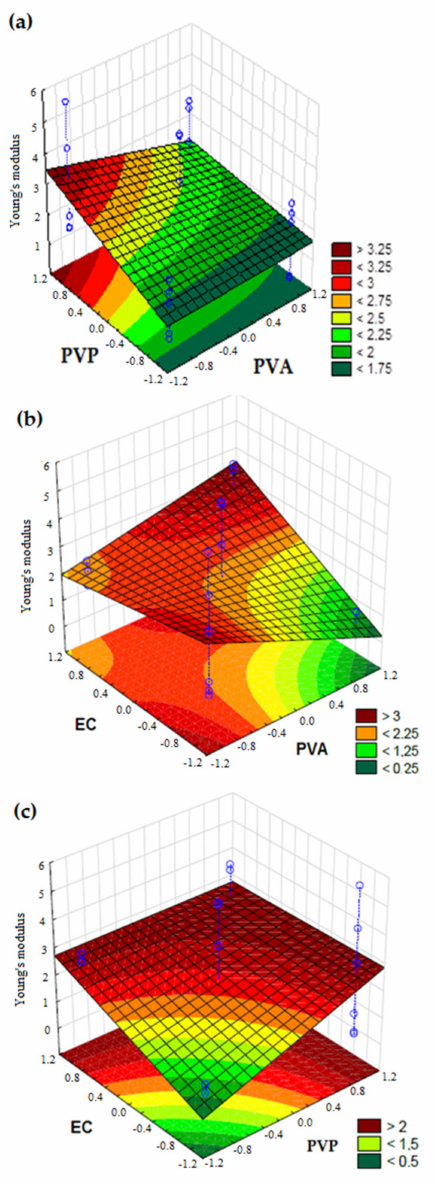
Figure 1. Response surface plots of mechanical tensional characteristic (Young’s modulus) of film formulations at 25 ◦ C as a function of: ( a ) PVA (X 1 ) and PVP (X 2 ); ( b ) PVA (X 1 ) and EC (X 3 ); ( c ) PVP (X 2 ) and EC (X 3 ). The color scale is indicated in each figure and shows the isoparametric values. The maximum tensile stress is indicated by the maximum point of a strain–stress